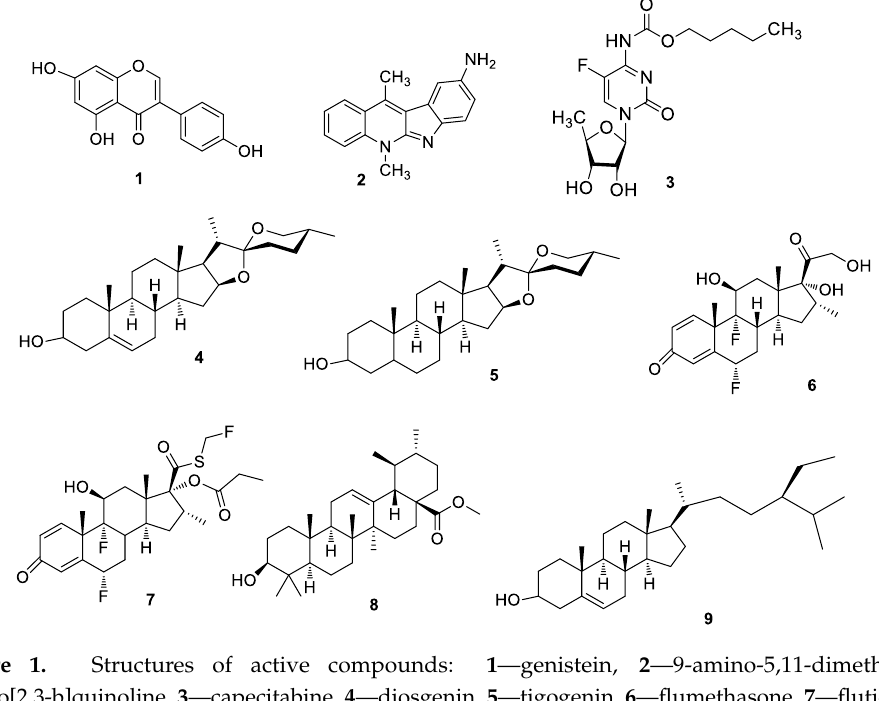
Structures of active compounds: 1 —genistein, 2 —9-amino-5,11-dimethyl-5 H -indolo[2,3-b]quinoline, 3 —capecitabine, 4 —diosgenin, 5 —tigogenin, 6 —flumethasone, 7 —fluticasone propionate, 8 —ursolic acid methyl ester, 9 —β-sitosterol.